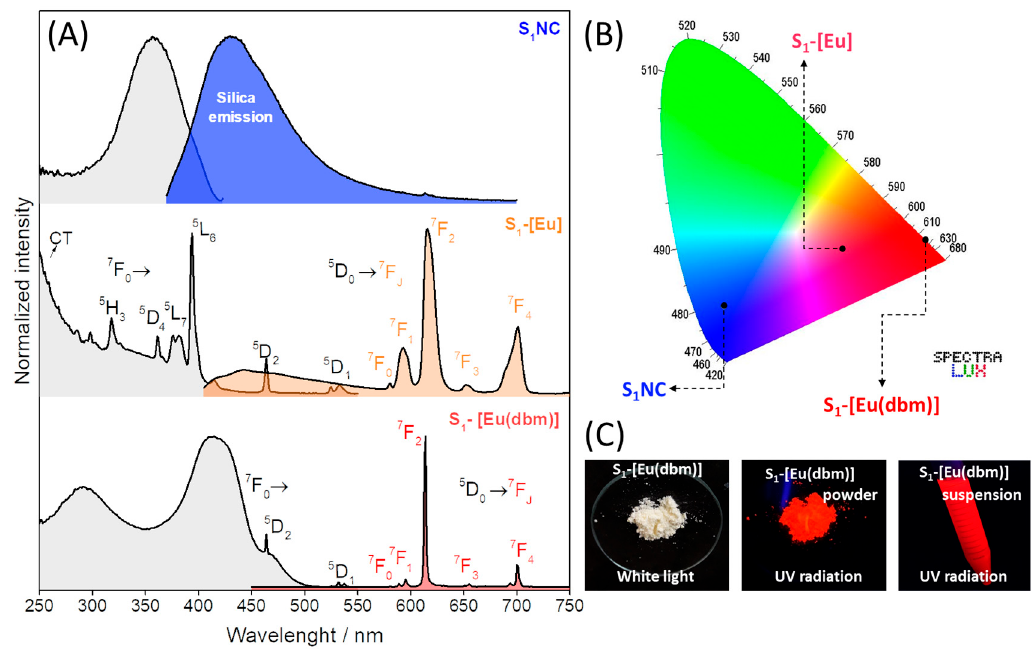
Figure 5. ( A ) Excitation and emission spectra (300 K) monitored at 433 and 356 nm for sample S 1 NC; 616 and 394 nm for sample S 1 -[Eu]; and 615 and 412 nm for sample S 1 -[Eu(dbm)], respectively. ( B ) 1931 CIE diagram of S 1 NC, S 1 -[Eu] S 1 -[Eu(dbm)] samples obtained from Reference [50]. ( C ) Photograph of S 1 -[Eu(dbm)] processed as powder or suspended in ethanol under white light and UV radiation (350 nm).